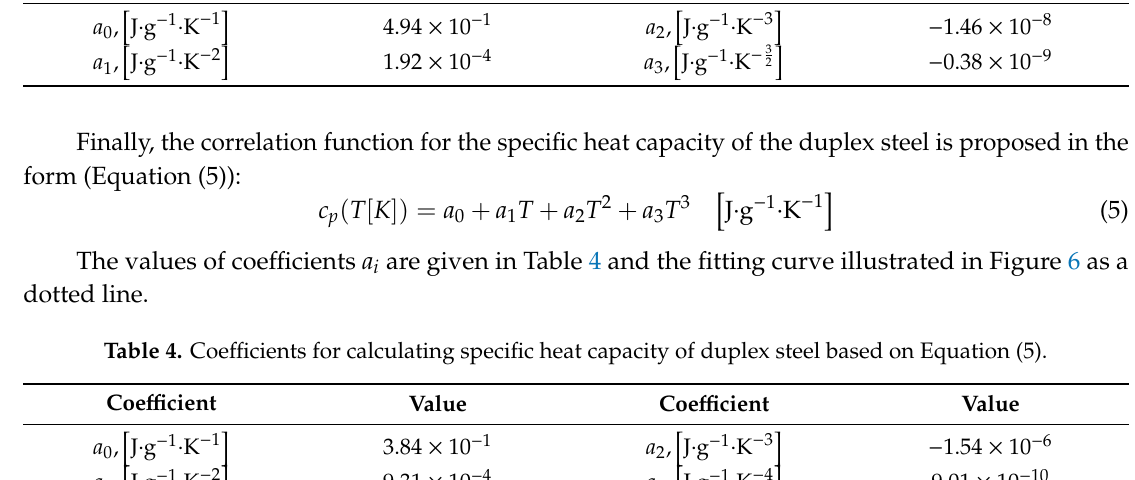
Table 3. Coe ffi cients for calculating specific heat capacity of 30HN2MFAJ steel based on Equation (4). Coe ffi cient Value Coe ffi cient Value (cid:104) − 1 (cid:105) a 0 , J · g − 1 · K